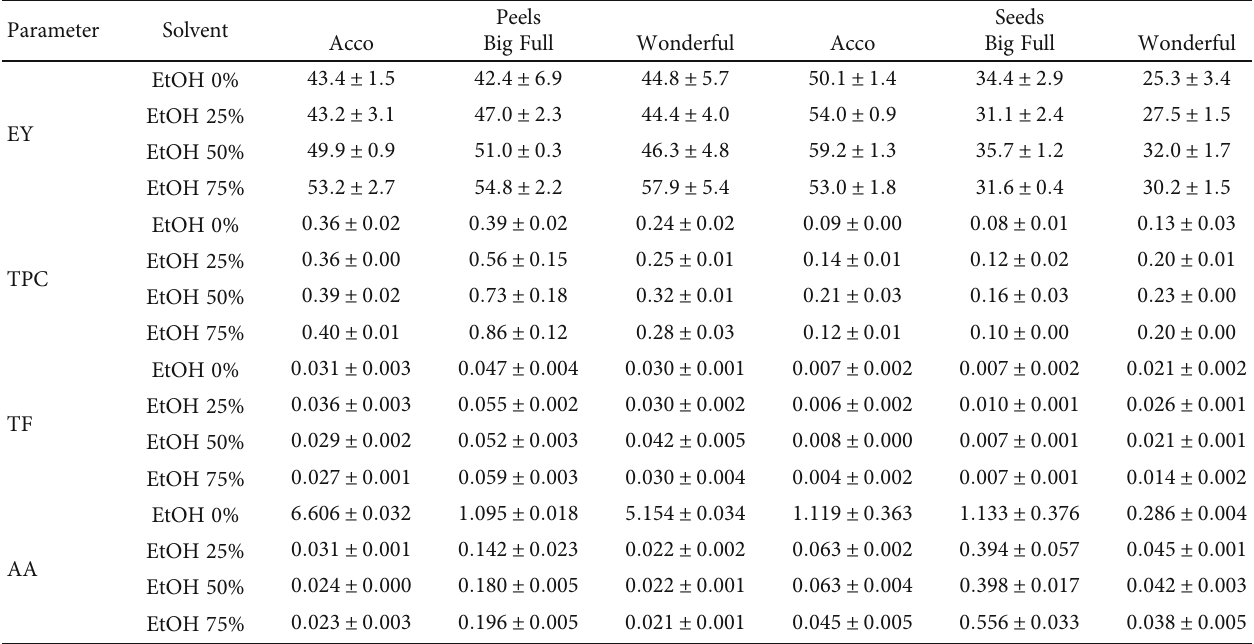
Table 3: Extraction yield (EY, %), total phenolic compounds (TPC, mg GAE/mg extract), total fl avonoids (TF, mg CATE/mg extract), and antioxidant activity (AA expressed as IC , mg/mL) of the peels and seeds of three pomegranate cultivars (Acco, Big Full, Wonderful) 50 according to ethanol/water extraction solvent (0%, 25%, 50%, and 75% EtOH, v/v).